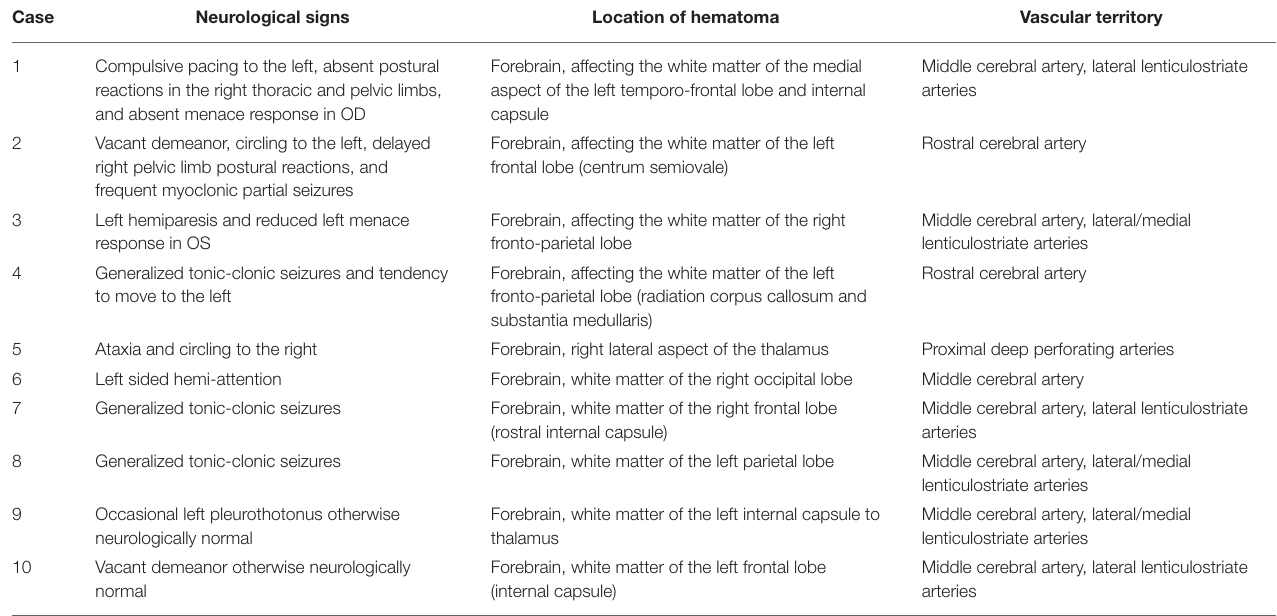
TABLE 3 | The neurological signs in each dog at first presentation displayed alongside the location of each intra-axial hematoma as revealed by magnetic resonance imaging and the likely vascular territory involved. Case Neurological signs Location of hematoma Vascular